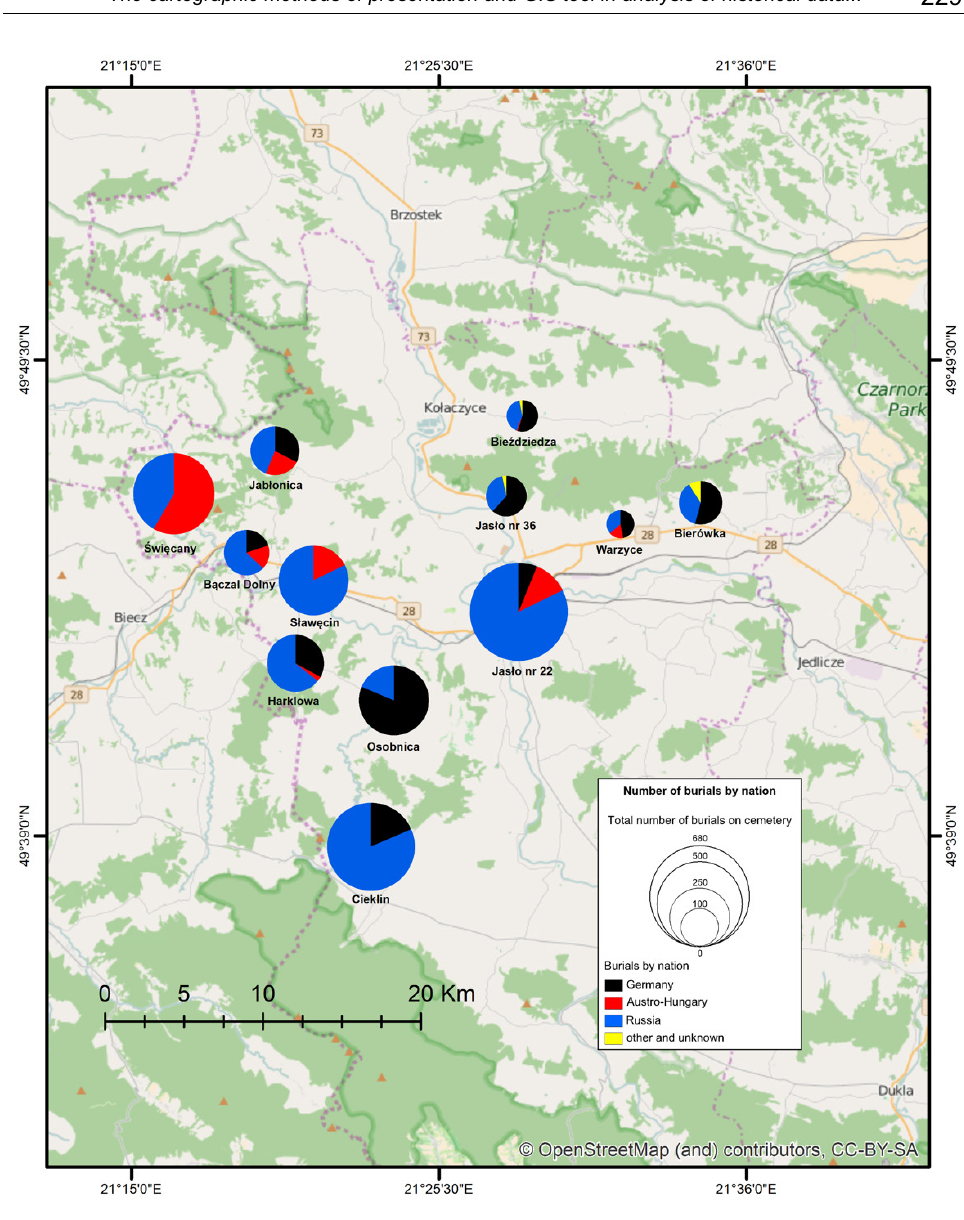
Fig. 3. Number of burials by nation per